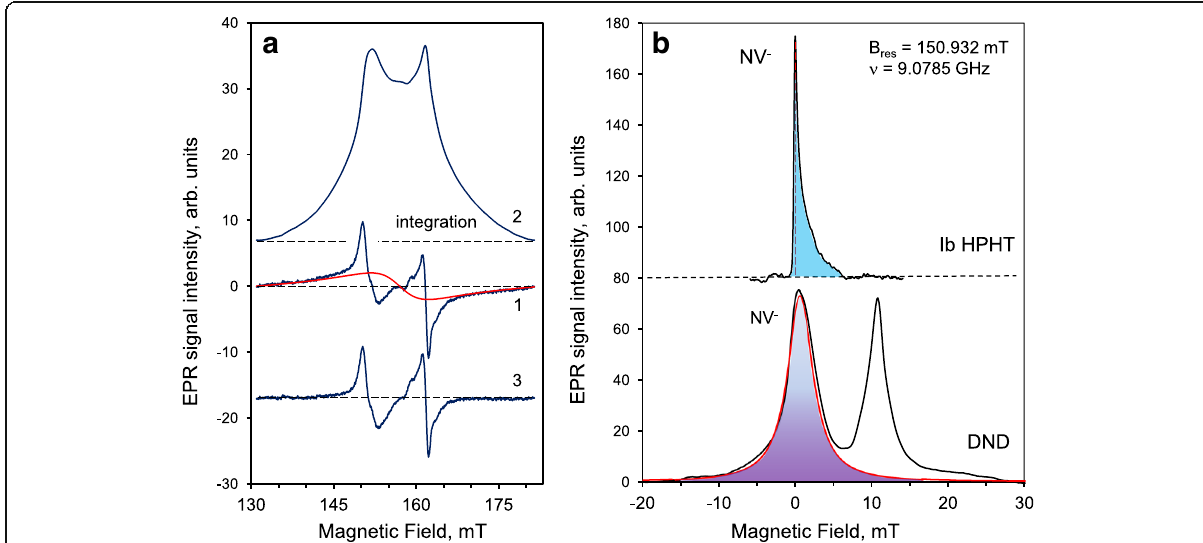
Fig. 4 a Background subtraction in EPR signal of DND and b estimations of the double-integrated intensities of the g =4.27 line for a DND sample and reference fluorescent Ib HPHT synthetic diamond. Panel a : as-registered first derivative EPR signal of the DND in the ±15 mT half magnetic field range (curve 1, blue); the same, but integrated EPR signal in the same ±15 mT range of magnetic field (curve 2); the same first derivative EPR signal of DND, but after subtraction of the broad parasitic EPR signal from remaining non-removable iron-containing paramagnetic complexes shown by red contour of Lorentzian shape in the upper curve (curve 3, blue). Panel b : Estimation of the double integrated intensity of the g =4.27 line for a fluorescent Ib HPHT diamond having NV − (upper curve, shaded area) and the DND sample (bottom curve, shadow area). The bottom spectrum in panel b consists of two contours of Lorentzian shape, one of which centred at lower magnetic field ( ≈ 150.932 mT), is assigned to the NV − centres of DND (the area below this contour in red is highlighted). Microwave frequency: ν